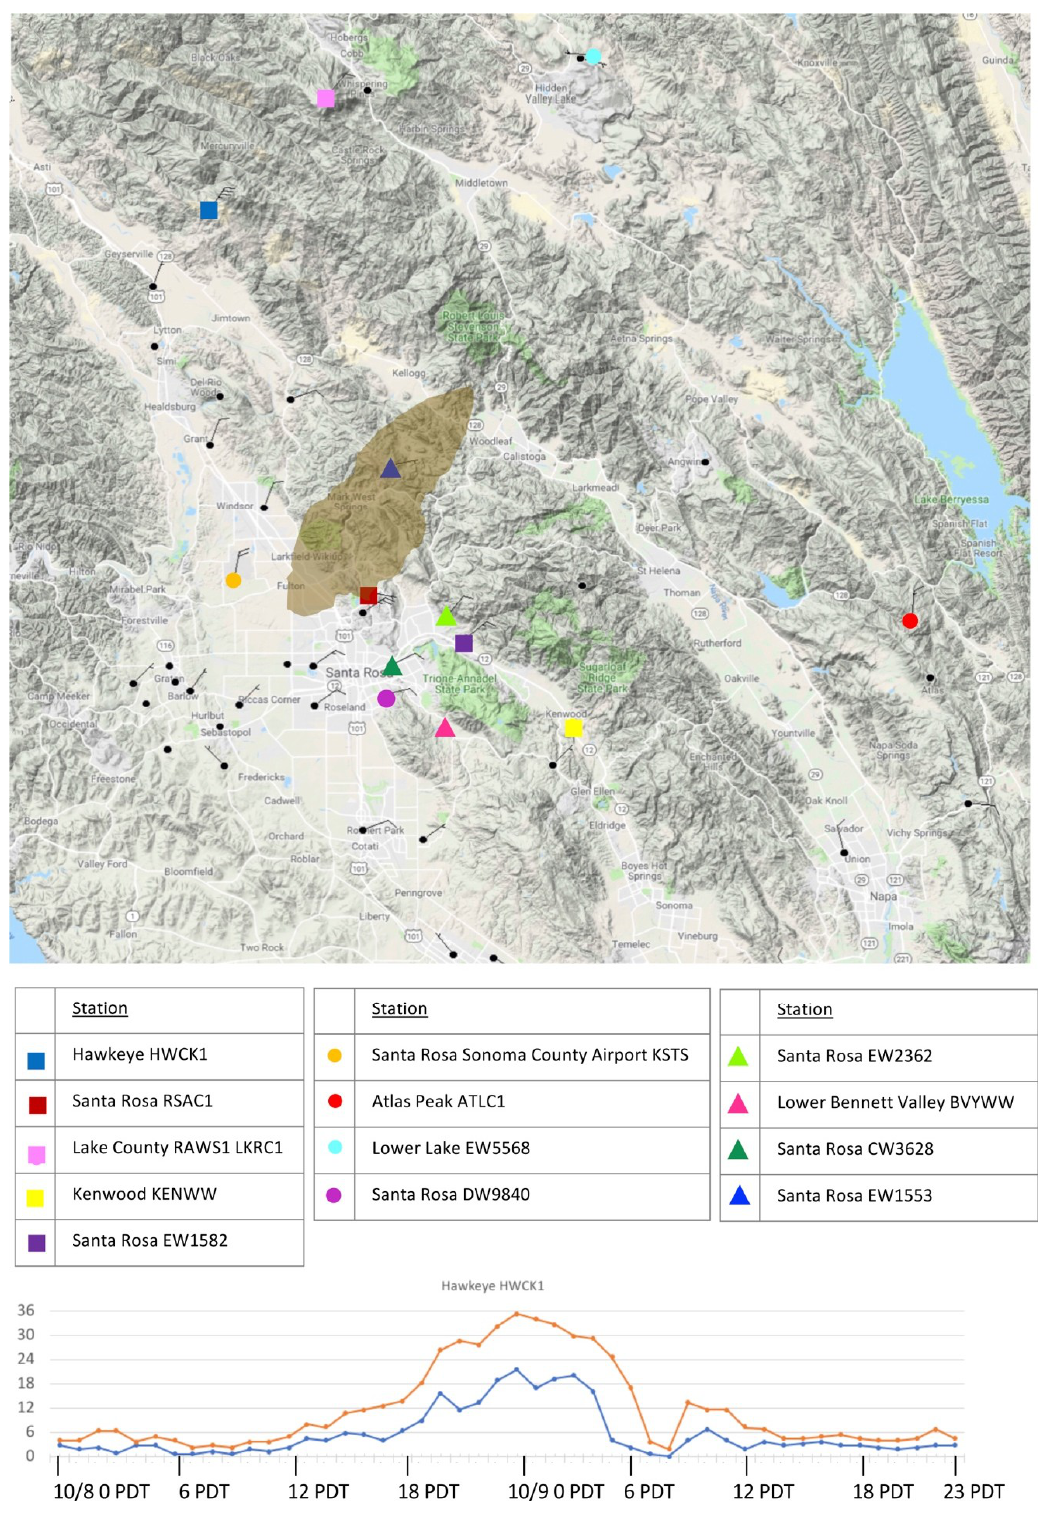
Figure 3. Surface station map where station wind barbs show most recent wind observation within 1 h ending at 8 a.m. UTC 10/9/17. Selected stations, ordered by decreasing peak wind gusts (stations with higher peak gusts marked with squares and lower peak gusts marked with triangles), are located with colored polygons (according to table). Wind speed (blue) and wind gust (orange) data (in m/s) from HWCK1, which recorded the highest wind speeds. Wind station data is available at http://mesowest.utah.edu. Tubbs Fire extent at 3:09 a.m. on 9 October from VIIRS is shown in brown.